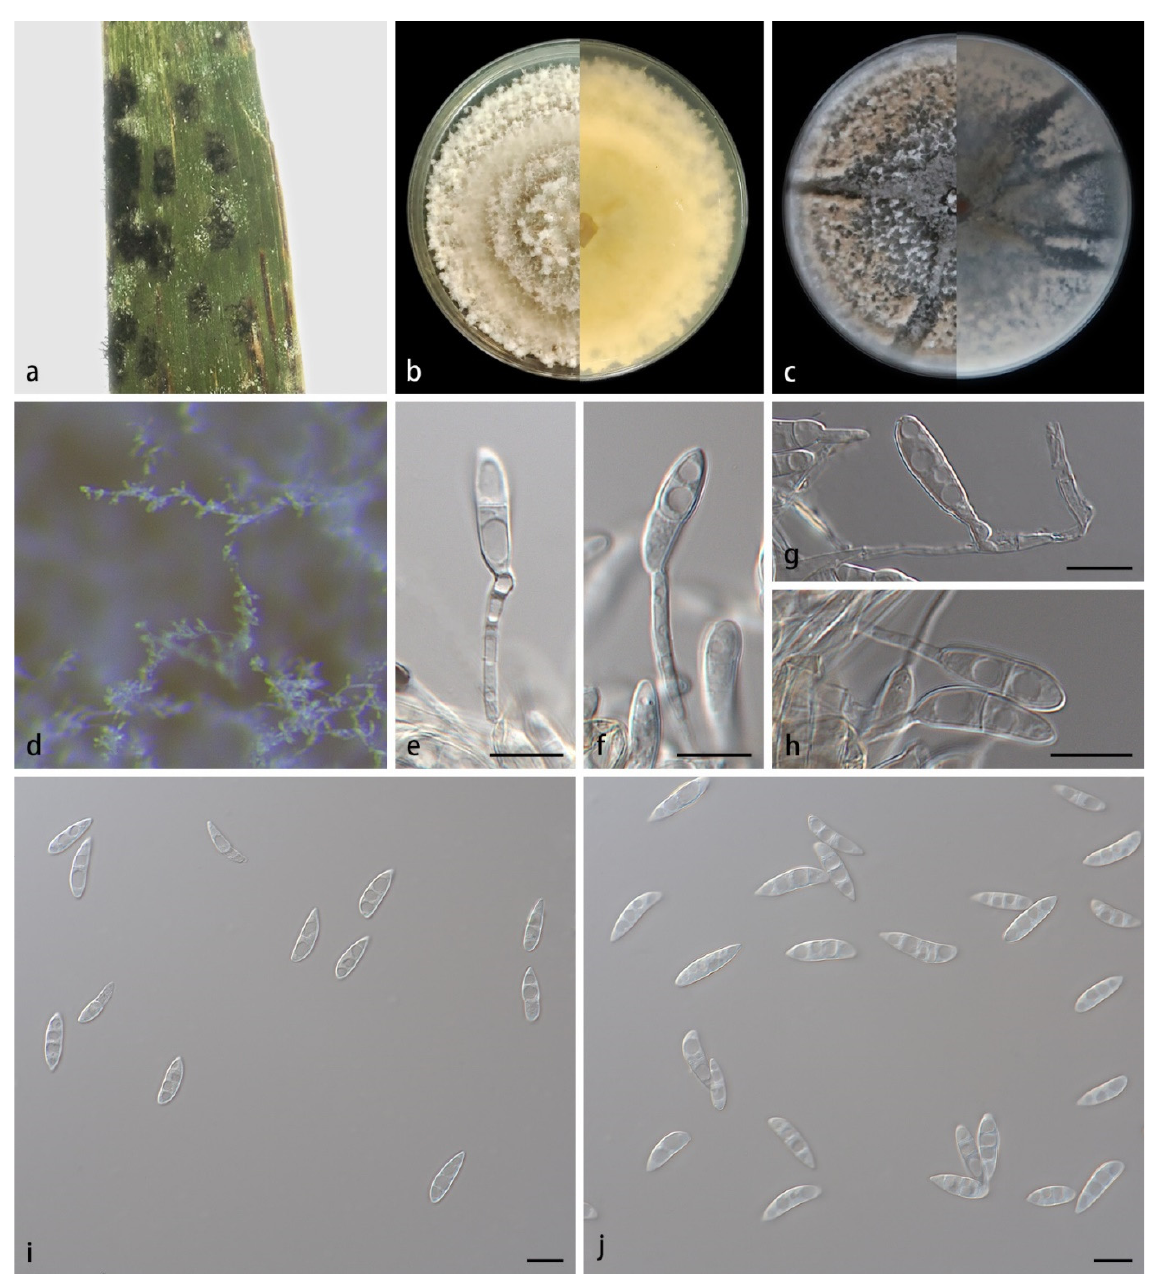
Figure 3. Microdochium sinense (holotype HMAS352154, ex-holotype SAUCC211097). ( a ) Leaves of host plant; ( b ) inverse and reverse sides of colony after 15 days on PDA; ( c ) inverse and reverse sides of colony after 15 days on OA; ( d ) colony overview; ( e – h ) conidiophores and conidiogenous cells; ( i , j ) conidia. Scale bars: ( e – j ) 10 μ m.